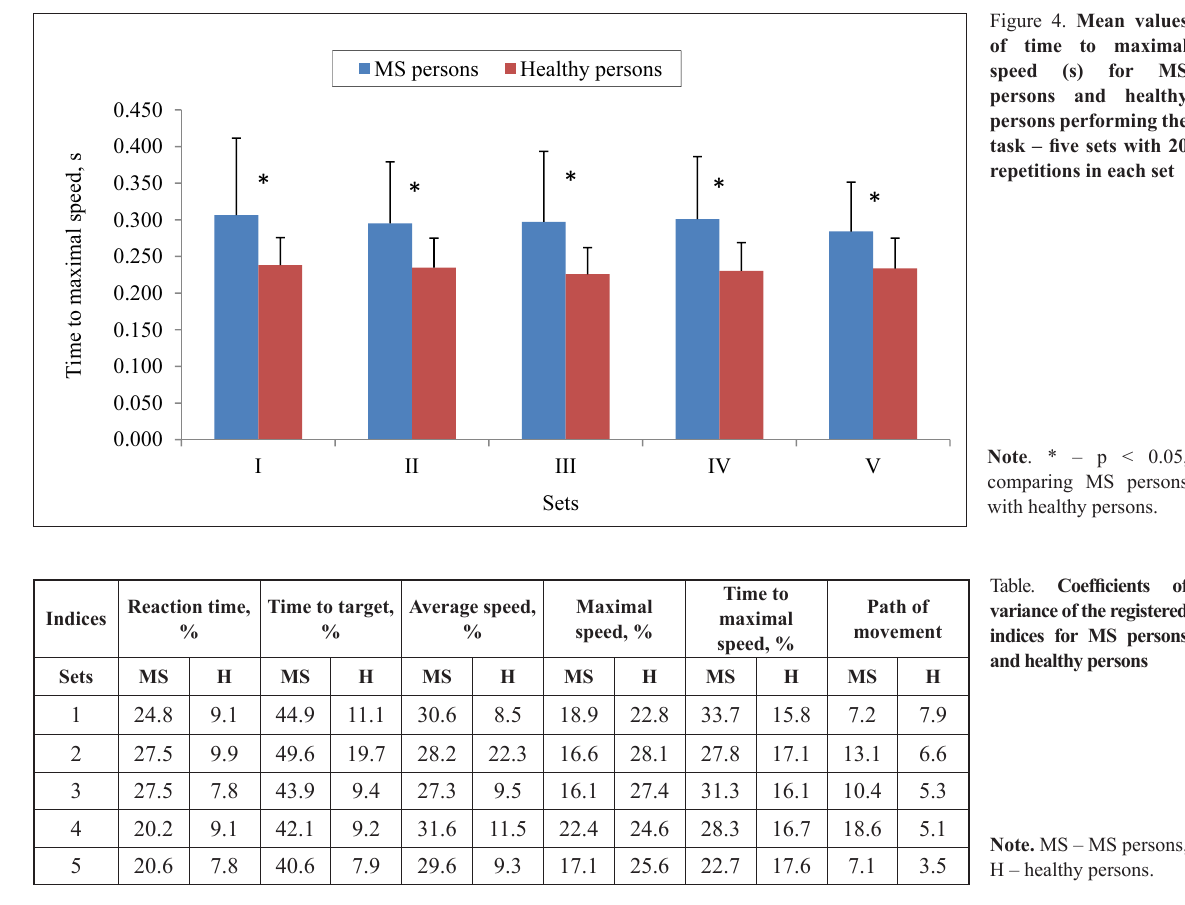
Figure 4. Mean values of time to maximal speed (s) for MS persons and healthy persons performing the task – five sets with 20 repetitions in each set